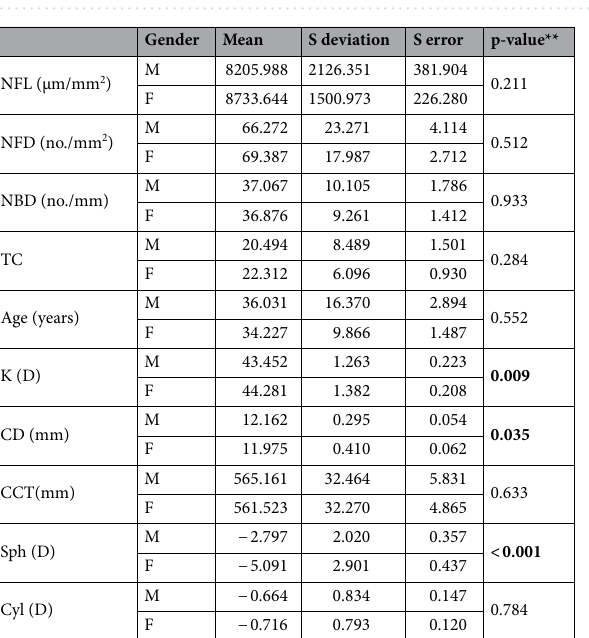
Figure 3. The example of the SBNP fibers from the left eye ( A ) and the right eye ( B ) of the same subject with low myopia.